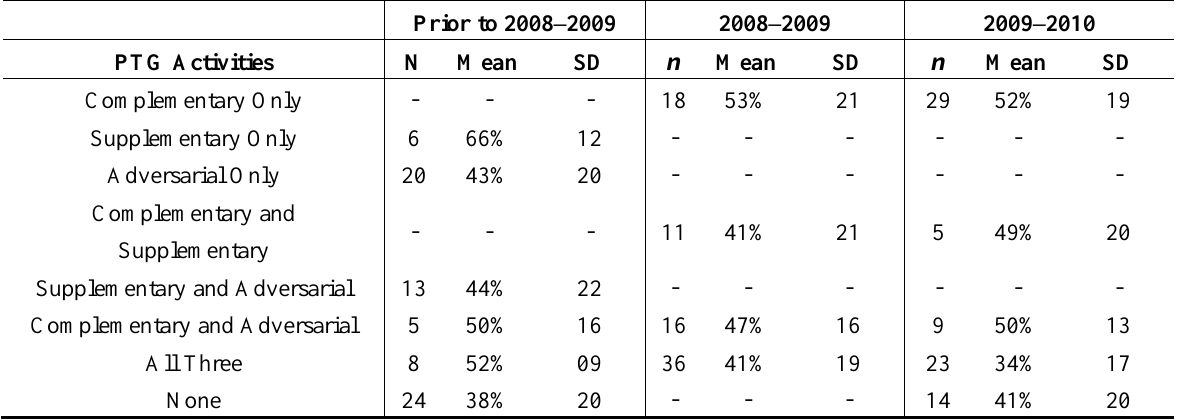
Table 1. Percent of students receiving free or reduced lunch by PTG activities and time period.